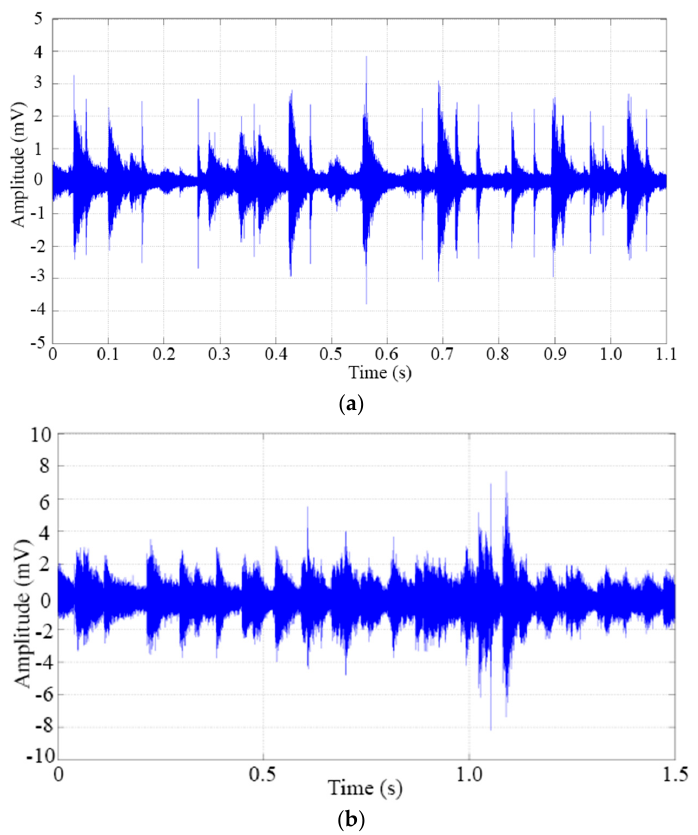
Figure 22. AE signals obtained during the diagnostics of shafts of roller bearings being in operation for ( a ) 2 and ( b ) 9 years. The corresponding RMS amplitudes are 0.9 mV and 2.2 mV.